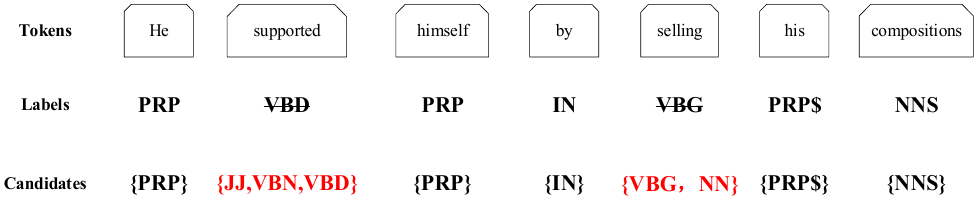
Figure 2. Masking partial POS tags. The POS tags of the token supported and the token selling are